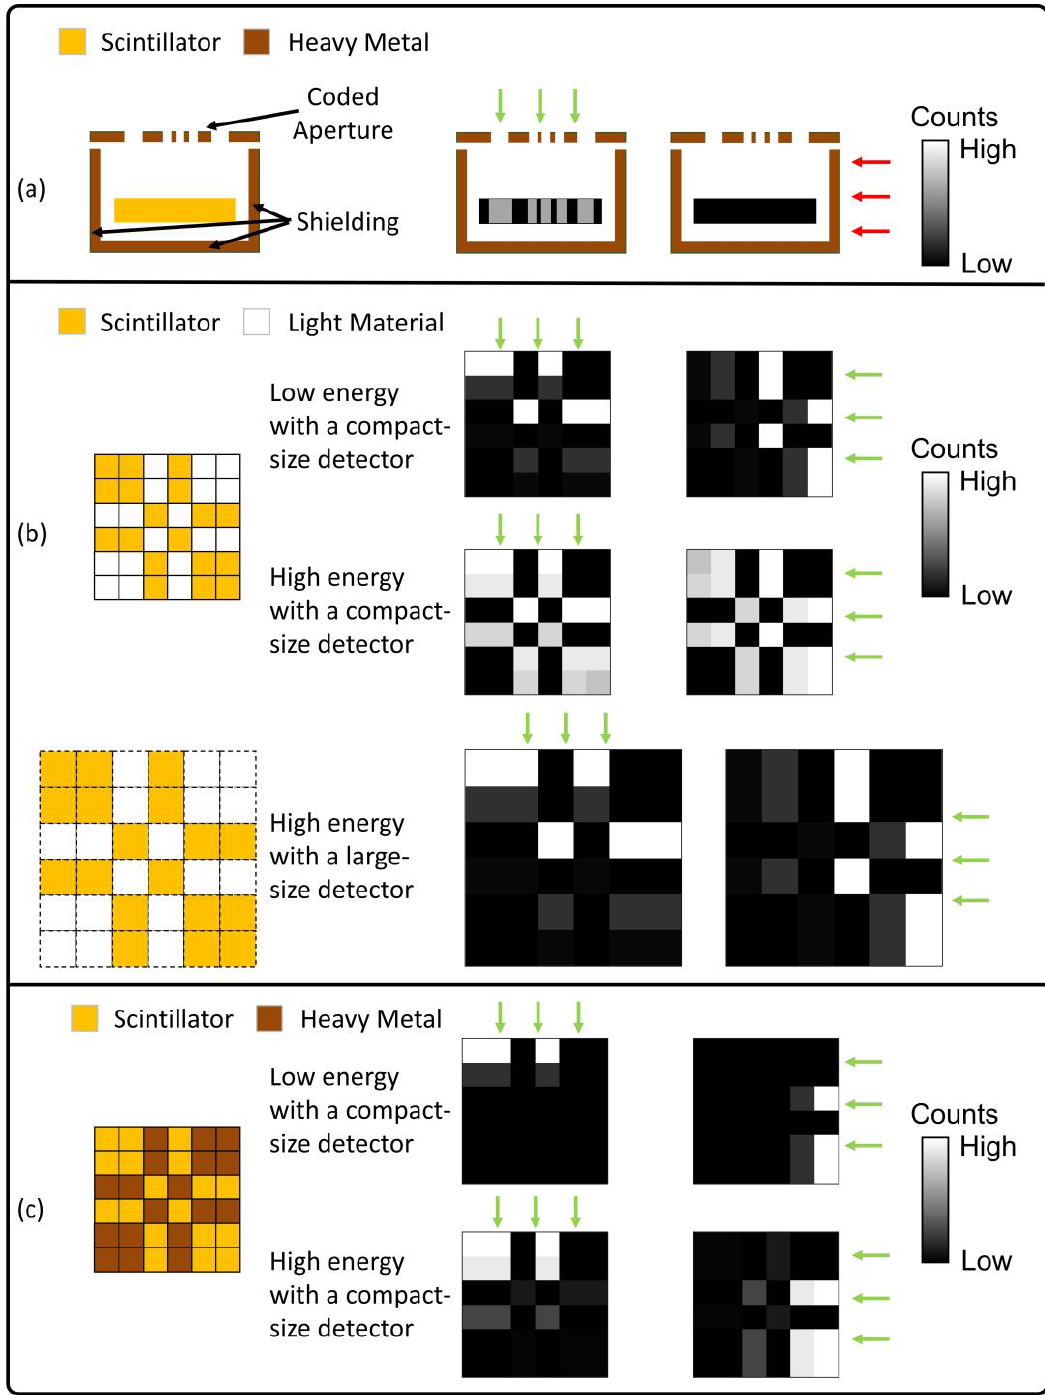
Figure 1. Gamma camera design concepts: ( a ) conventional gamma camera with a heavy metal collimator ( b ) previously proposed gamma camera using mosaic patterned scintillators and ( c ) proposed gamma camera using scintillators and embedded heavy metal elements.